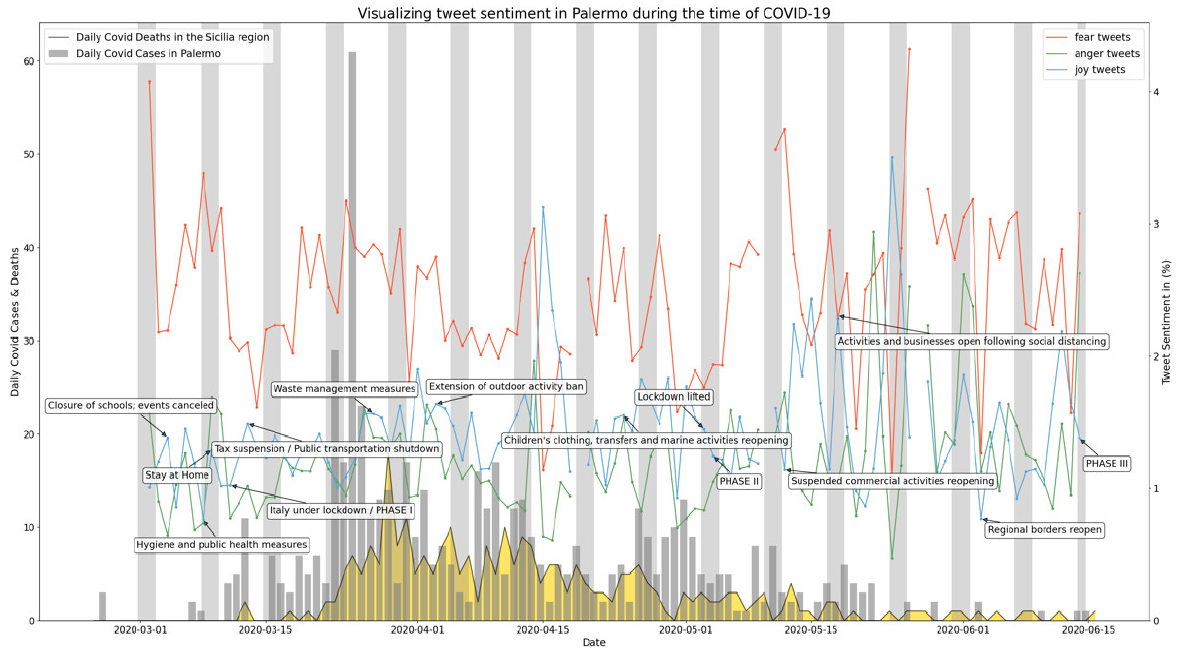
Figure A9. Visualizing Twitter sentiment in Palermo during the time of COVID-19.